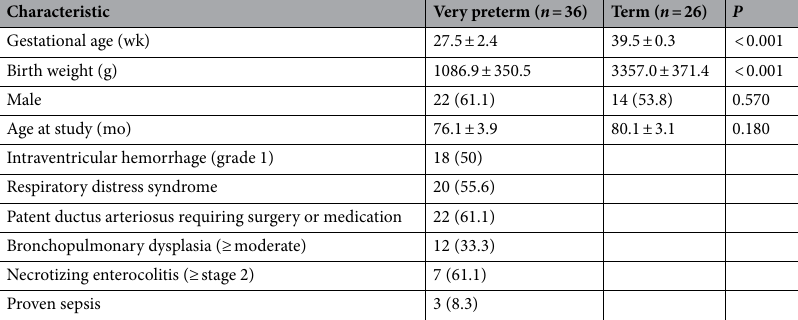
Table 2. Children born preterm had significantly lower scores on all included subscales of the WISC-IV than term-born controls. After adjusting for multiple comparisons, there were no significant differences in the CBCL scores between the children born very preterm and controls.